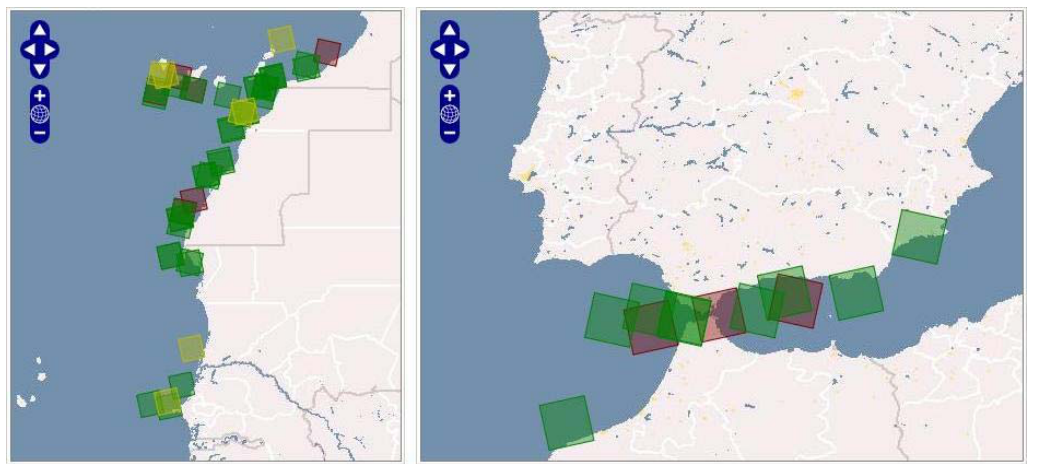
Figure 10. Mapping of the datasets used in the results shown in Section 4.